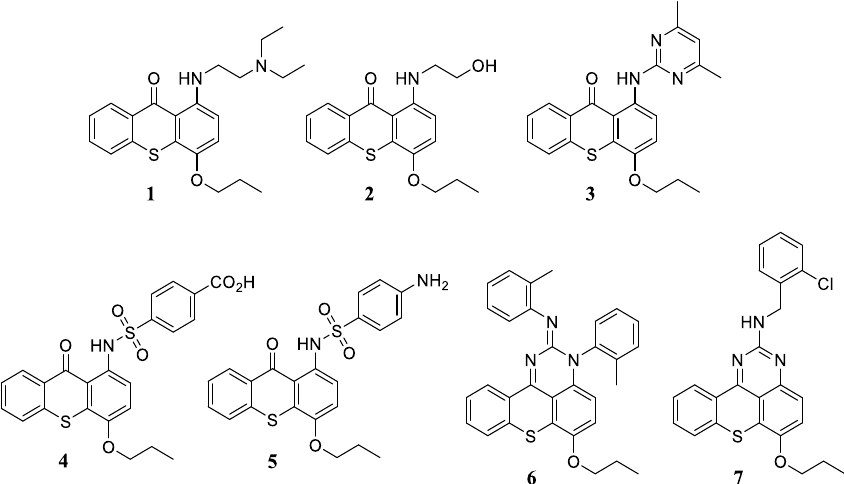
Figure 1. Structures of the in-house library of compounds ( 1 – 7 ).